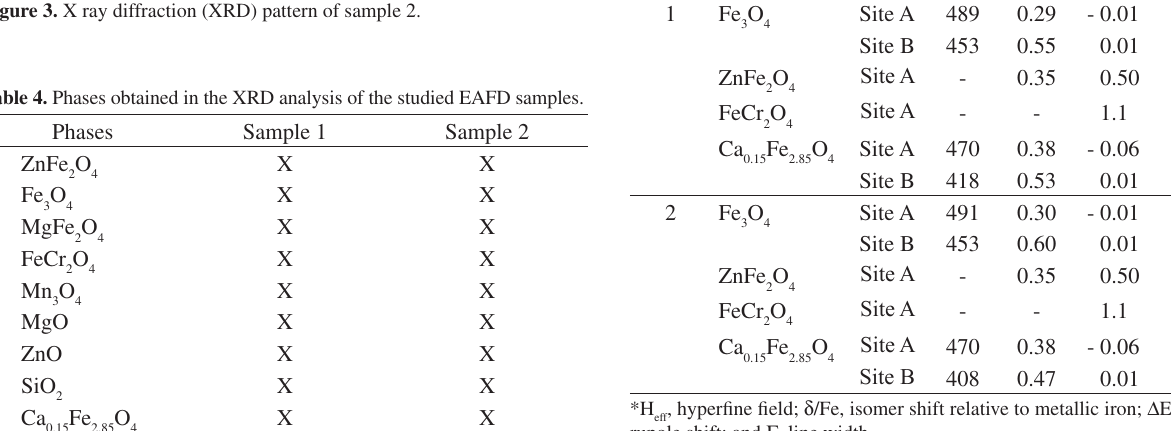
Figure 3. X ray di��ractio� (XRD) patter� o� sample 2.